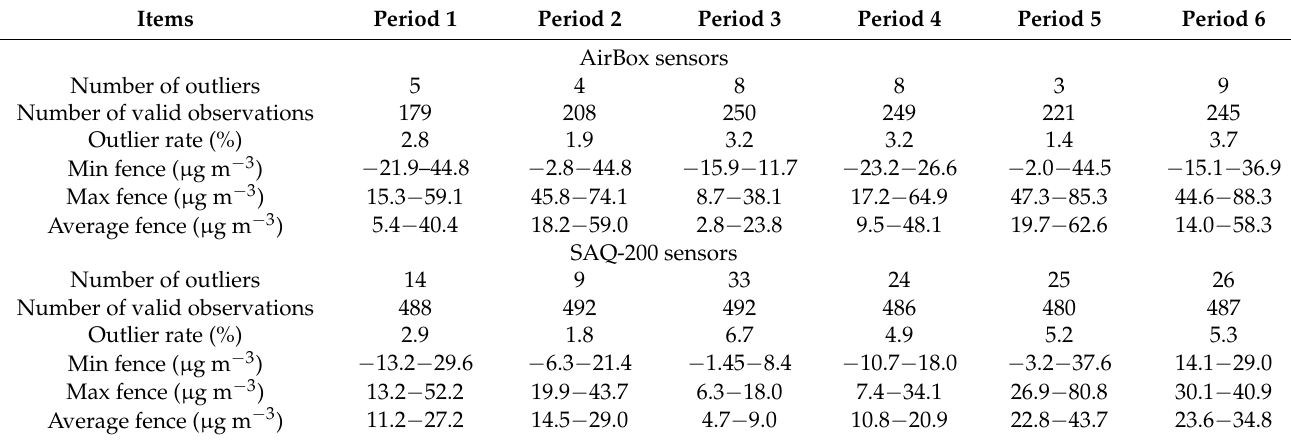
Figure 11. Same as Figure 10, but observed data were from the SAQ-200 sensor system and blue dots were outliers. Table 1. Summary of the outlier detection results of observed data from the two low-cost PM 2.5 sensor systems at 12:00 p.m. Thursday of a representative week in each two-month period,